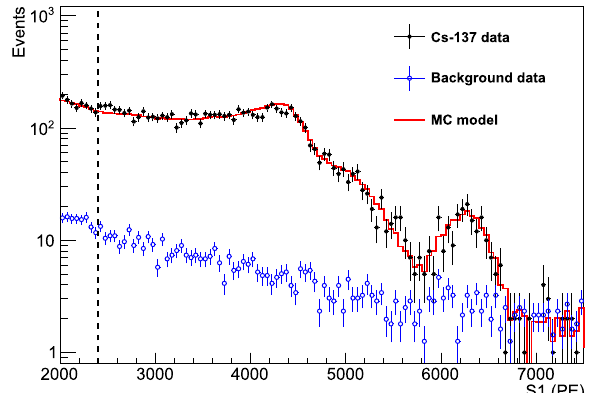
Fig. 9 S1 distribution from 133 Ba (left) and 137 Cs (right) calibrations takeninsingle-phasemodeatnullfield,withnoTBAcorrectionapplied. Each distribution is superimposed with the normalised environmental